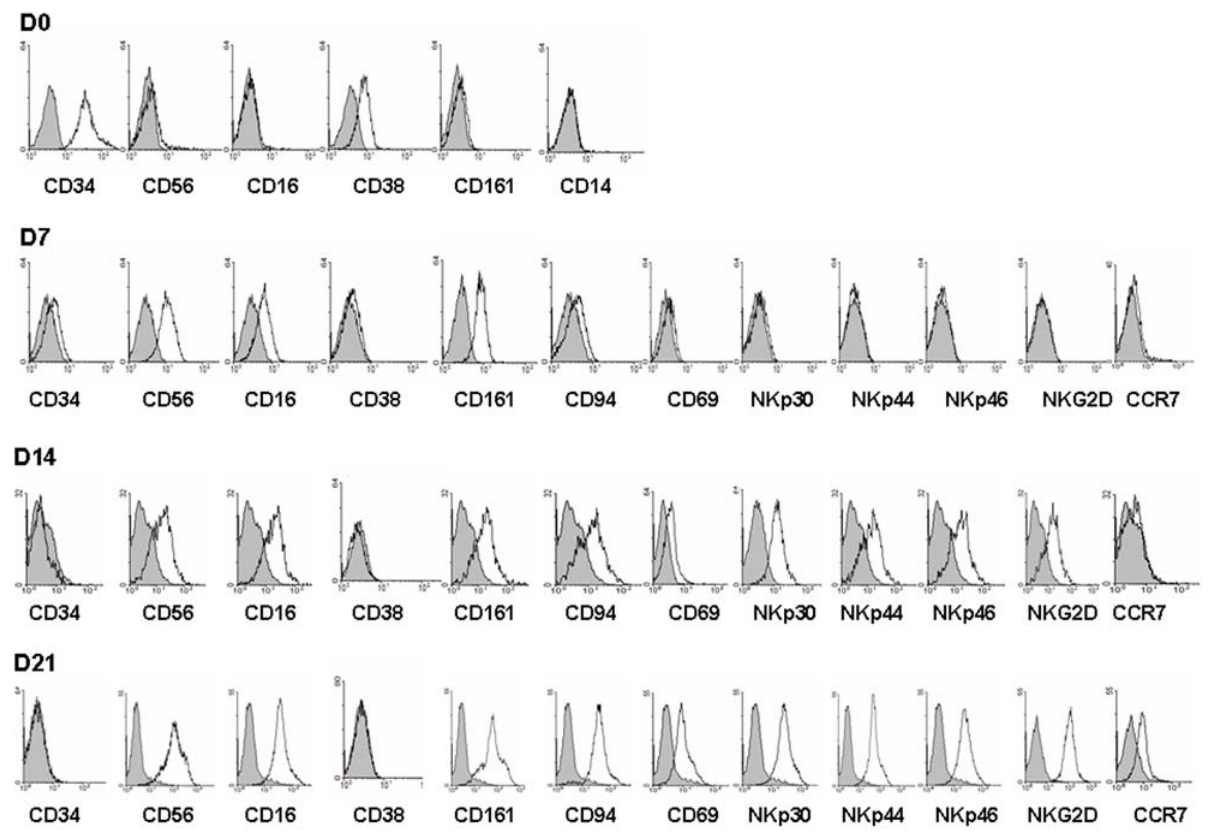
Figure 2. Autonomous NK commitment of PB-HP . Commitment into the NK pathway of PB-HP was evaluated by flow cytometry at different times in culture, analyzing CD34, CD38 and the NK markers CD56, CD16, CD161, CD94, NKp30, NKp44, NKp46, NKG2D, CD69 and CCR7. Shadowed peaks represent staining with isotype control Abs. Continuous lines represent staining with the indicated Abs. The frequency of PB-HP represents about 0.1% of mononuclear cells of the peripheral blood. The data are representative of more than 30 separate experiments.